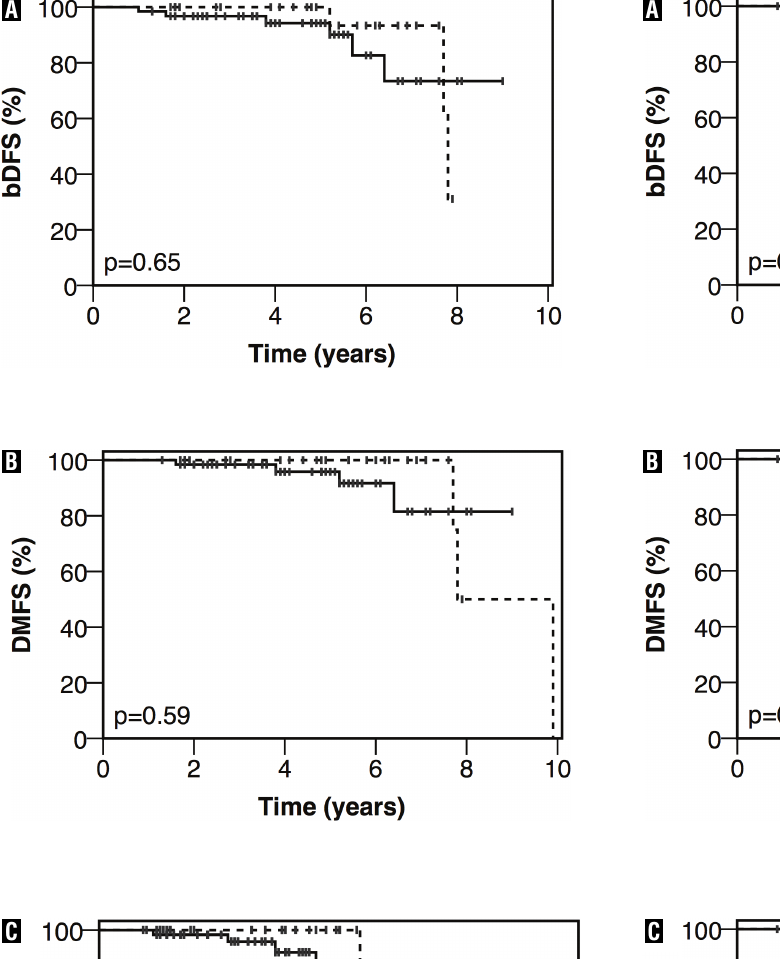
1 - Kaplan-Meier estimates of bDFS (a), DMFS